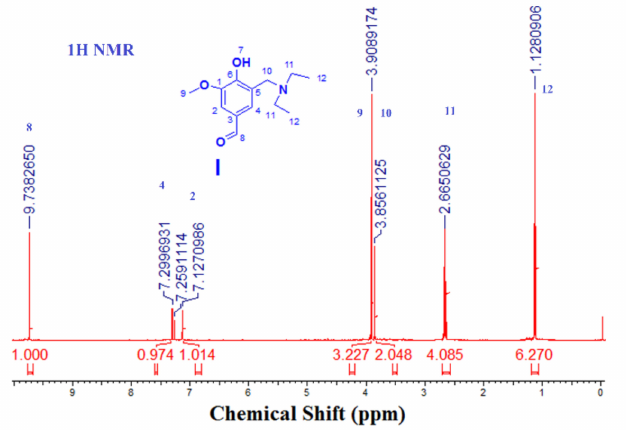
Figure 2. 1 H NMR spectrum (CDCl 3 ) of